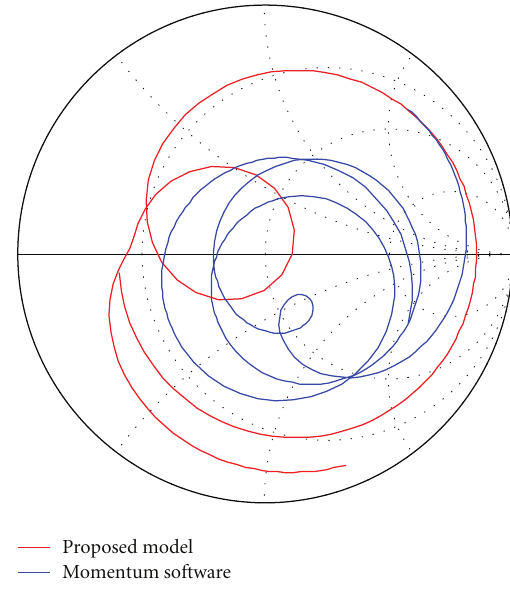
Figure 12: Smith’s chart of the input impedance locus.